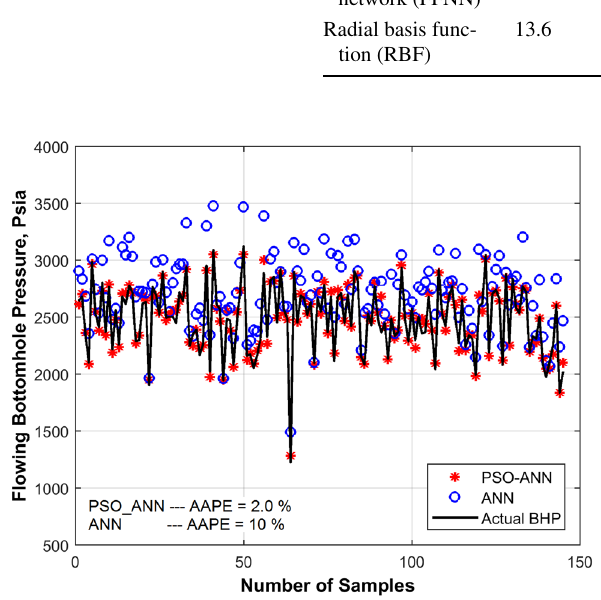
Fig. 4 FBHP prediction using optimized and unoptimized models (training dataset)